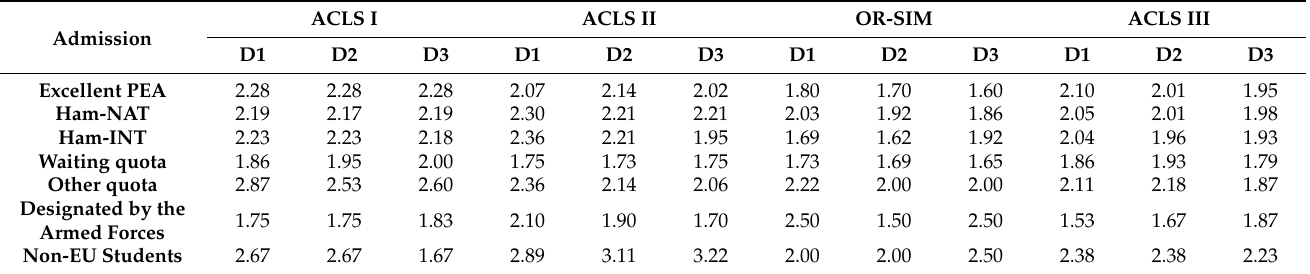
Table 3. NTS performance of the admission cohorts for each training session and each dimension of the